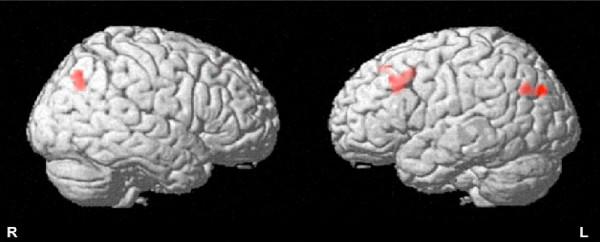
Spatial distribution of functional brain MRI activation.